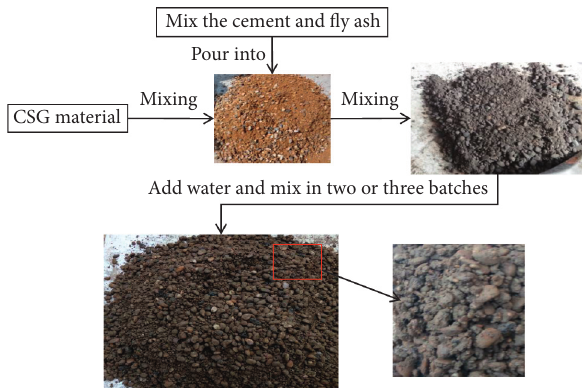
Figure 1: CSG material mixing process.